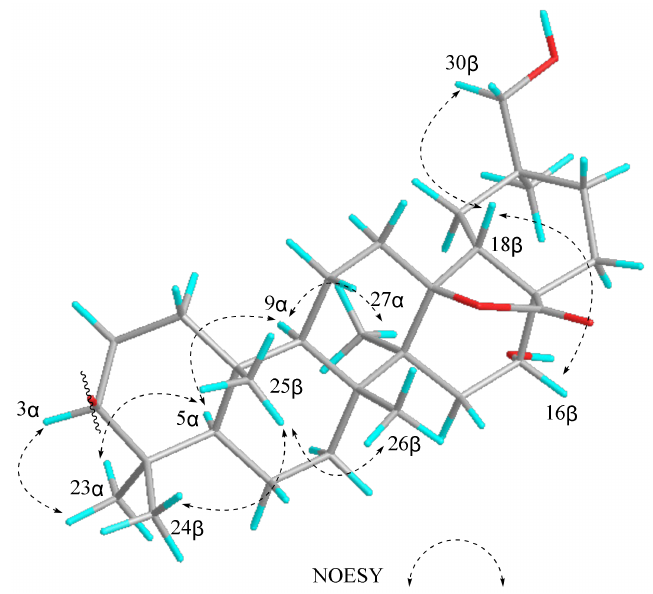
Figure 2. Key NOESY correlations of the aglycon of ardisiacrispin D ( 1 ).